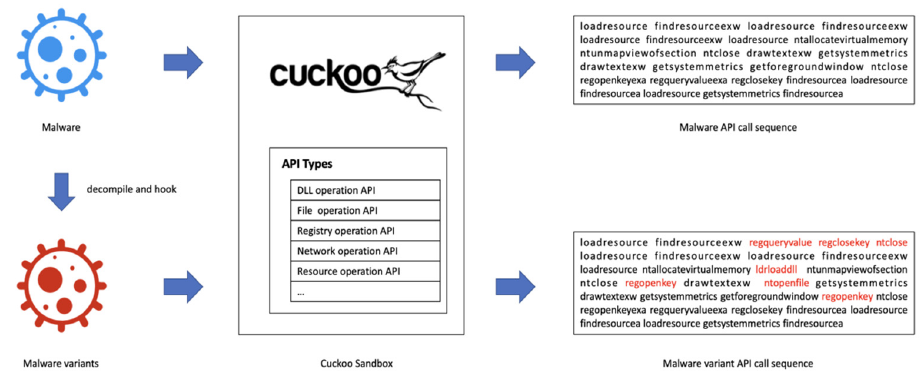
Figure 5. Extraction process of the malware variant API sequence dataset.